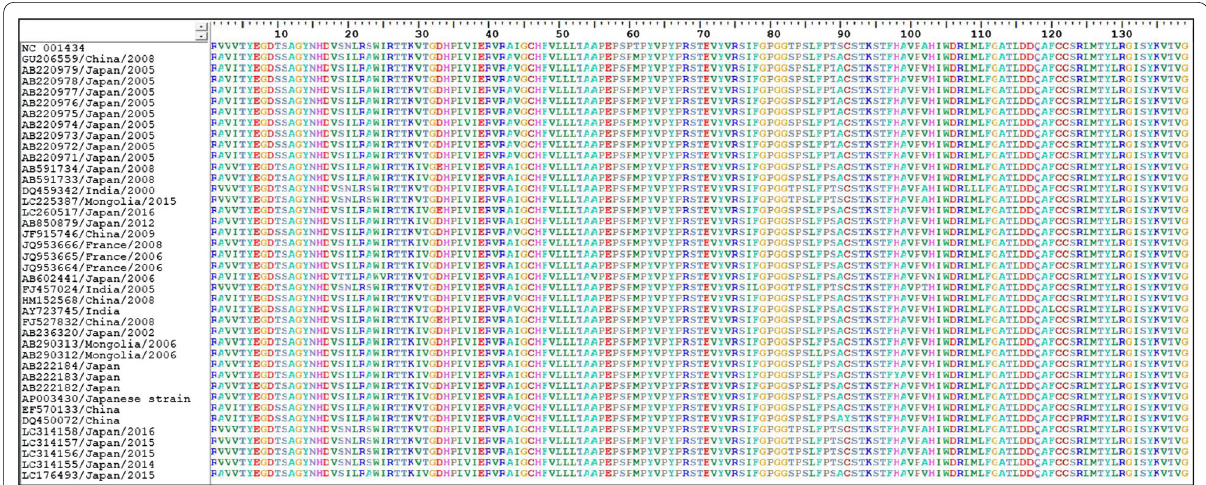
Fig. 2 Alignment of amino acid sequences in Y-domain protein genes of HEV genomes showing the sequence conservation in different hosts across all genotypes. The analysis includes a total of 50 sequences